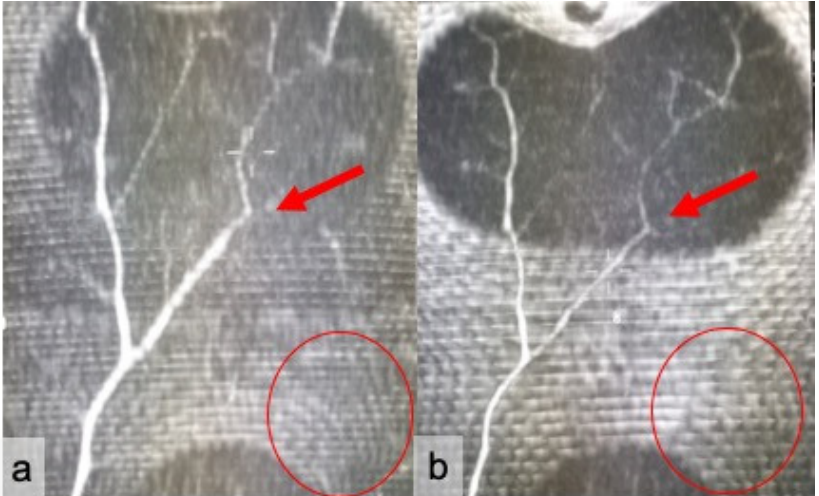
Figure 6. Assessment of superficial venous communications running between the right and left portion of the abdomen. Coronal sub-volume maximum intensity projection (MIP) reconstructions of the superficial abdominal wall for cCT ( a ) and CTa ( b ) show a large venous trunk on the right hemi-abdomen (red arrows), with a 3 score. Superficial inferior epigastric vein integrity was absent on the left (red circles).